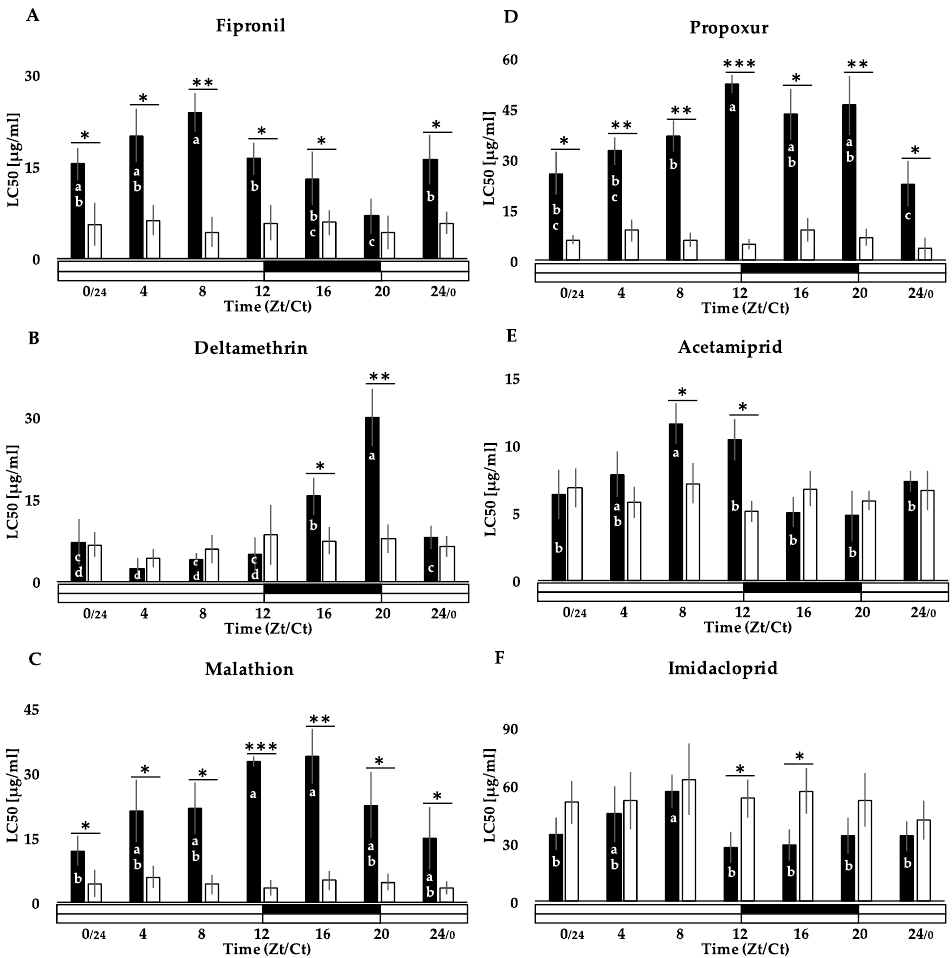
Figure 1. Exposure to continuous light affects daily susceptibility patterns and results in increased sensitivity to insecticides in larvae (the flowchart of the experiment is shown in Scheme 1A). The 2-day-old larvae of the 6th instar were exposed to fipronil ( A ), deltamethrin ( B ), malathion ( C ), propoxur ( D ), acetamiprid ( E ), and imidacloprid ( F ) at various concentrations for one hour at a given time point. Data are shown as the average LC50 ( ± SEM) at 24 h after exposure to insecticides for larvae kept under LD (black bars) and LL (white bars) conditions in three independent experiments. Significant differences between LD and LL mean values at a given time point, with * p < 0.05, ** p < 0.01, and *** p < 0.001, were calculated by ANOVA and unpaired t -test. Differences between time point mean values within LD and LL groups were determined by an ANOVA and Bonferroni post-test; different letters inside the bars denote significant differences at p < 0.05. Horizontal bars represent day (white) and night (black) portions of the photo-regime with Zt (Zeitgeber time)/Ct (Circadian time) indicated below.